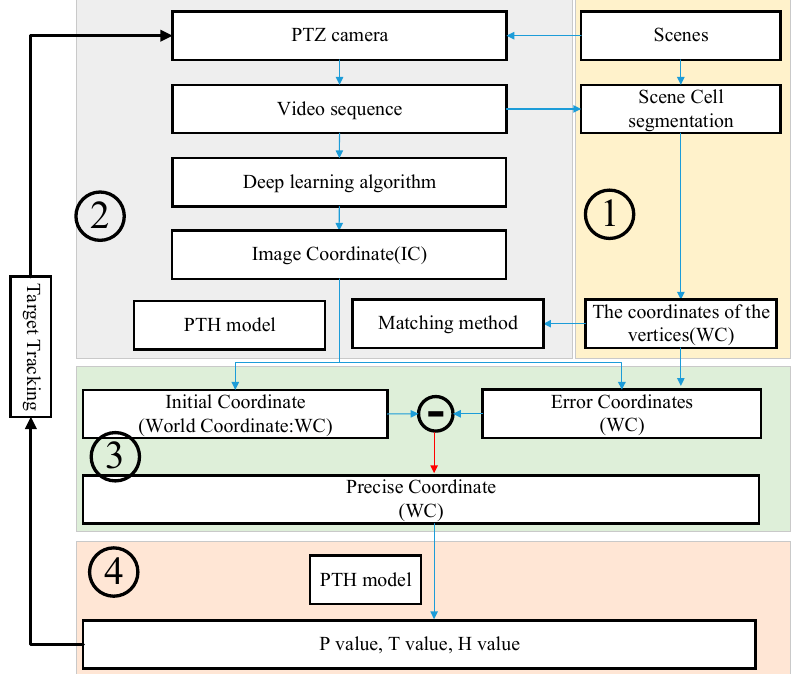
Figure 1. The overall flow chart of the proposed method.